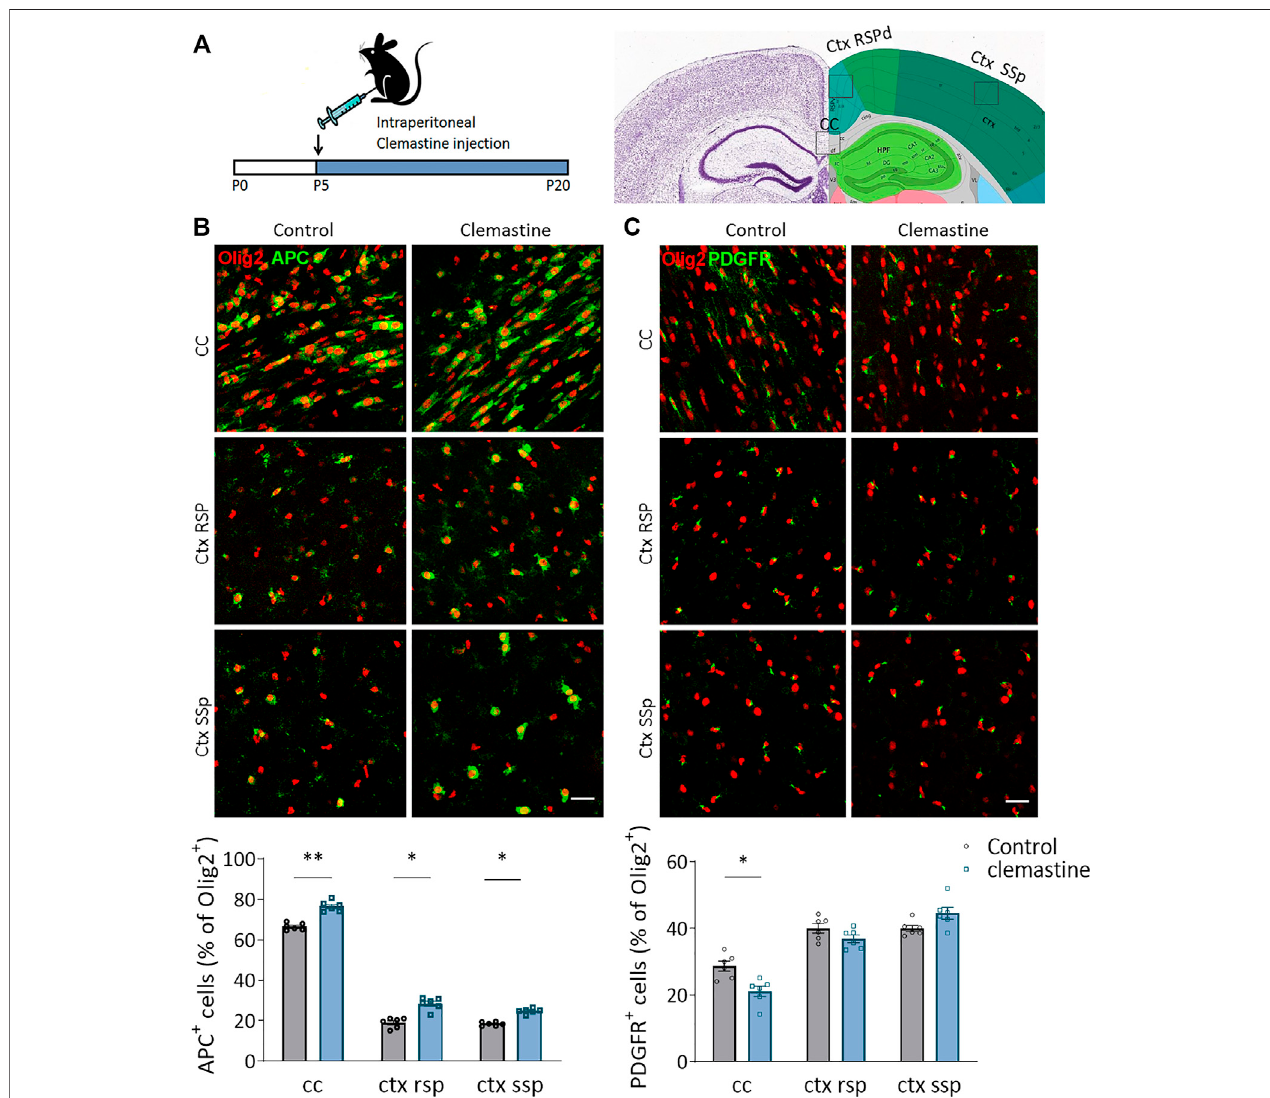
FIGURE 1 | (A) Schematic representation of clemastine treatment (50 μ g/kg; i.p.) during development. The analysis was performed in corpus callosum (cc), retrospinal cortex (ctx rsp) and primary somatosensory cortex (ctx ss) at postnatal day 21 (P21). (B,C) Compressed confocal z stack images of APC + mature oligodendrocytes [ (B) ; green] and PDGFR + oligodendrocyte progenitor cells [ (C) ; OPCs; green] in cc, ctx rsp and ctx ss of control and clemastine-treated mice. Below, averageofthepercentage ofmatureoligodendrocytes (B) orOPCs (C) vs totalOlig 2+ oligodendroglialcells( n =6mice per experimental group). Scalebar=50 μ m * p < 0.05, ** p <